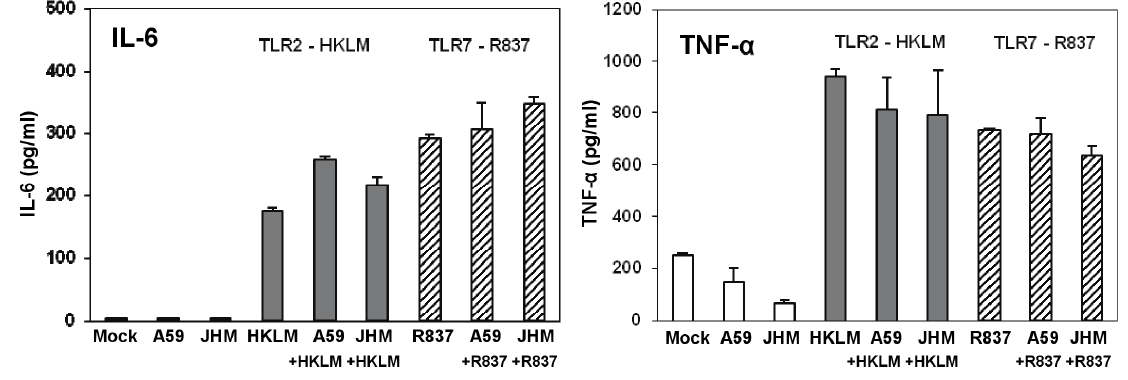
Figure 7. IL-6 and TNF- α production in cell-free supernatants from J774A.1 macrophages stimulated with TLR ligands, MHV-infected, and/or coactivated during MHV infection. J774A.1 cells were prestimulated for 6 h with HKLM (10 8 cells/mL), LPS (5 μ g/mL), R837 (5 μ g/mL), and poly I:C (0.25 μ g/mL); media was removed and: 1) a second challenge of the corresponding TLR ligand (same concentrations) was added to the cells for 18 h; 2) cells were prestimulated for 6 h with the TLR ligands as above; media was removed and cells infected with MHV-A59 or MHV-JHM at 1.0 MOI for 1 h of adsorption in the absence of the ligands; after virus adsorption cells were stimulated with a second challenge of the TLR ligands using the same concentrations as during prestimulation and samples were taken at 18 h; 3) cells were not TLR activated and only infected with MHV-A59 or MHV-JHM at 1.0 MOI for 1 h of adsorption in the absence of the ligands; fresh media was added to the cells for 18 h. Non-stimulated, non-infected J774A.1 cells were used as mock control. Cell-free supernatants were taken at 18 h from TLR-activated alone, infected alone, and TLR-activated and infected and assessed for IL-6 and TNF- α using ELISA. Error bars represent the standard error of the mean of two independent experiments, each done in